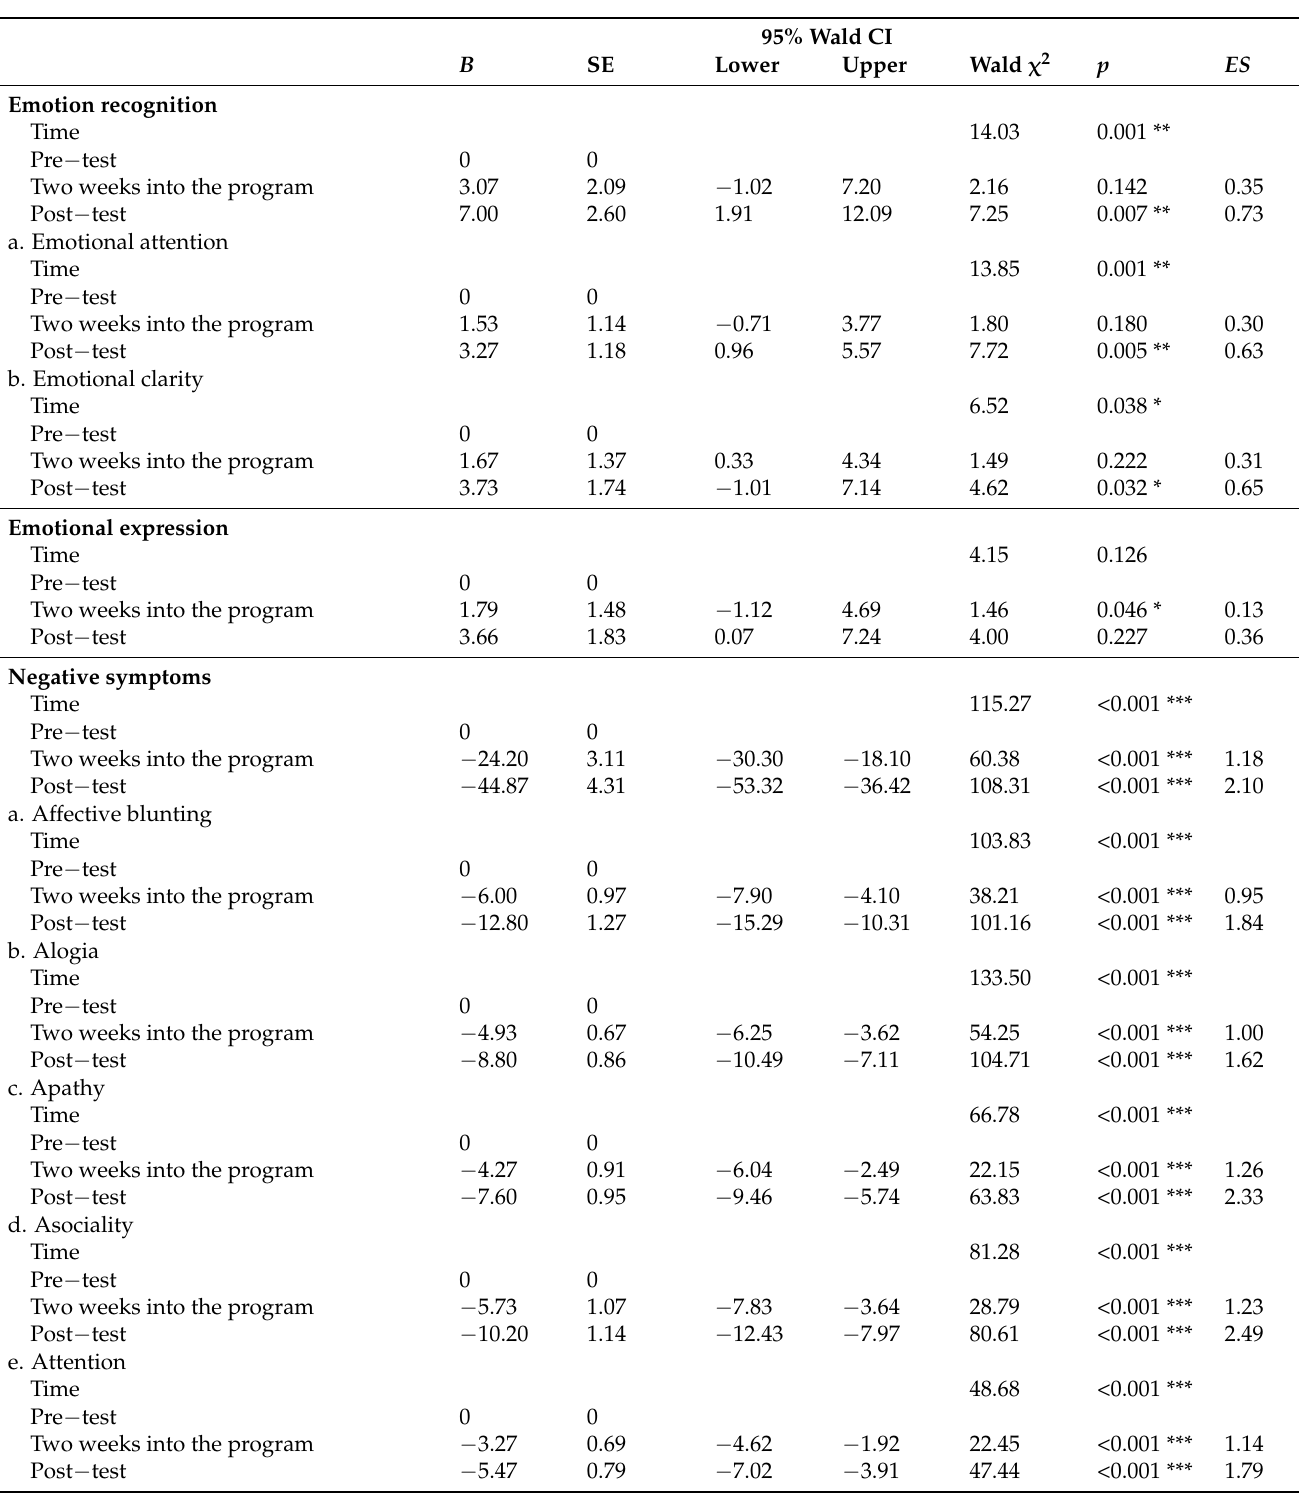
Table 4. Effects of the short emotional management program (EMP-S) on participants’ emotion perception, emotional expression, and negative symptoms ( n =